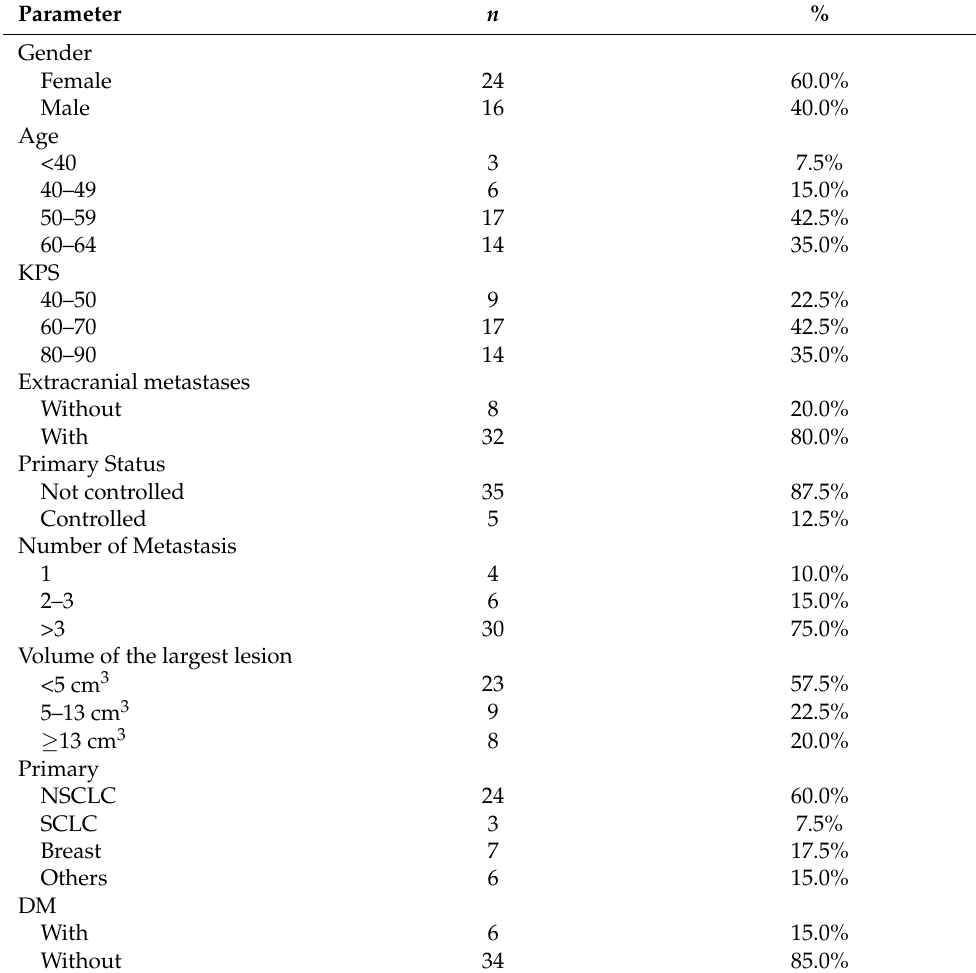
Table 1. Demographic data of all non-elderly brain metastasis